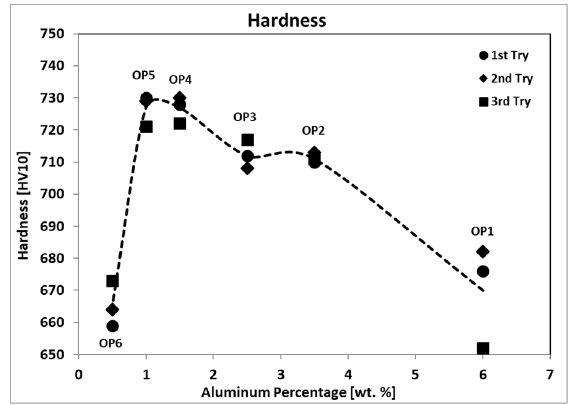
Figure 4. Hardness (HV10) at room temperature (RT).